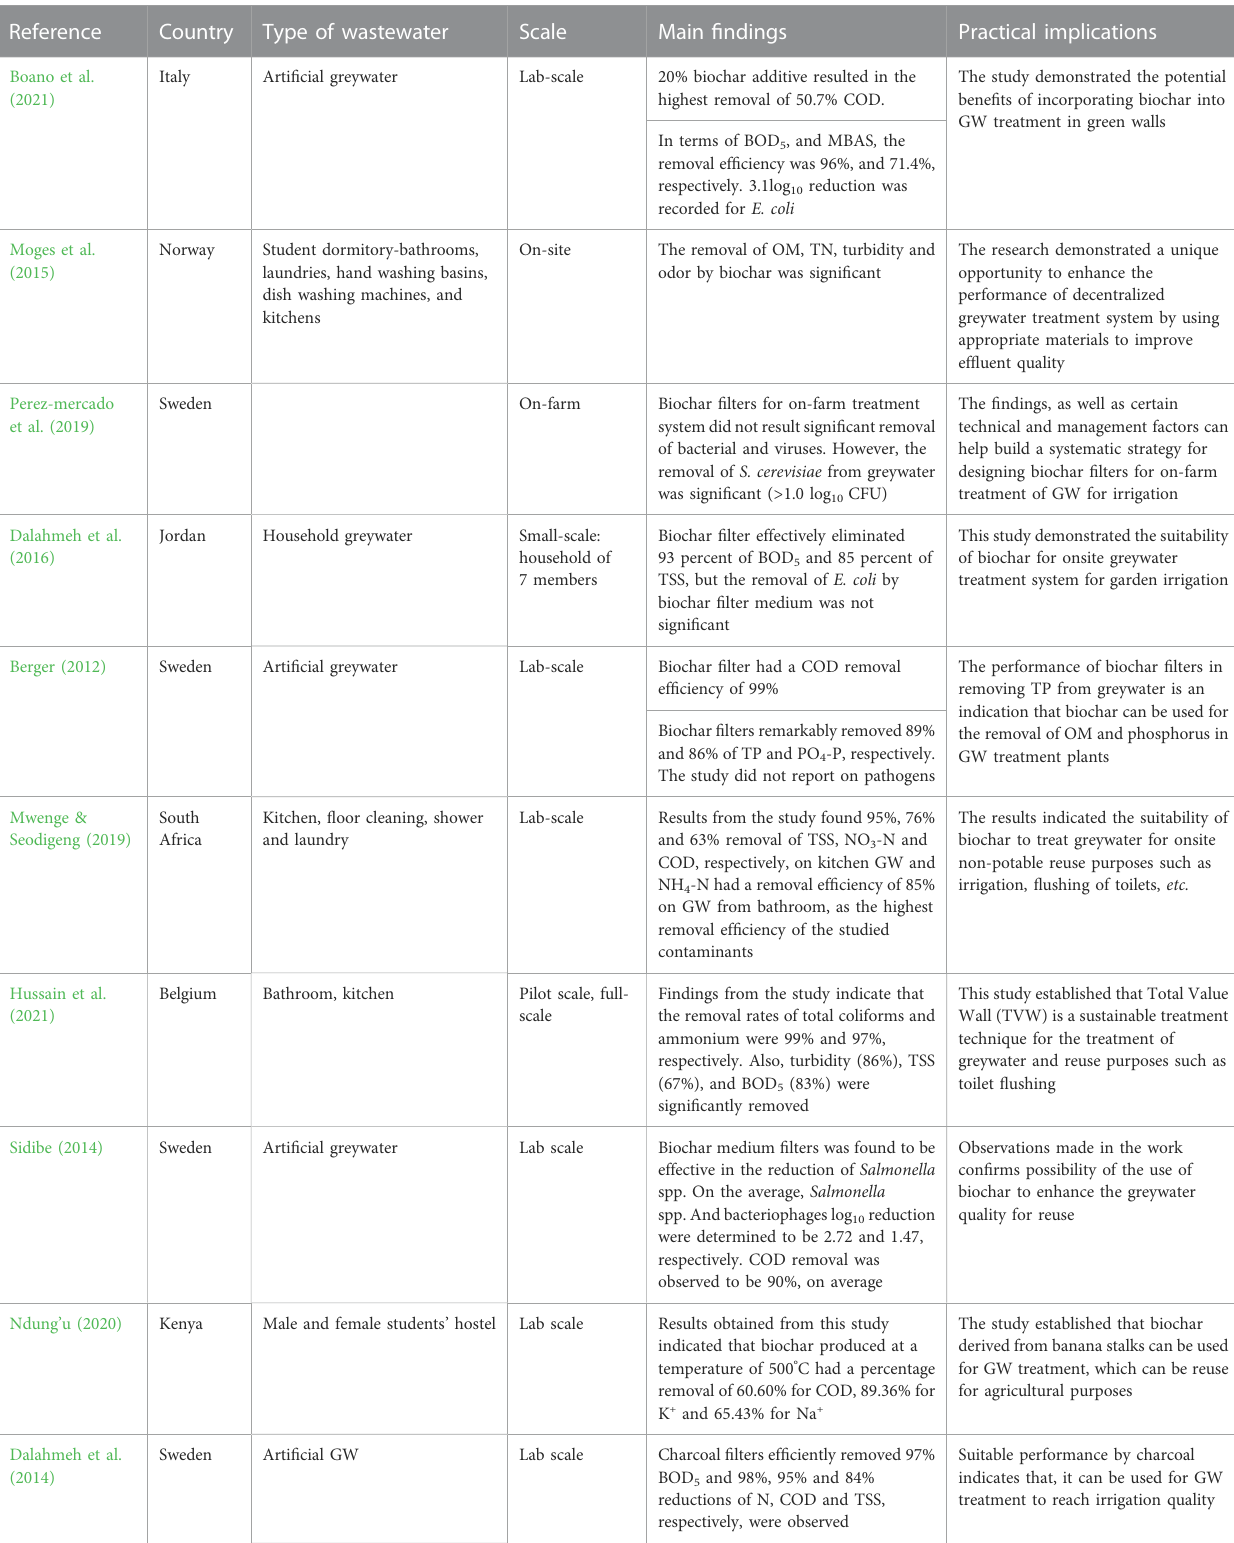
TABLE 6 Summary of the effect of biochar on household wastewater treatment.